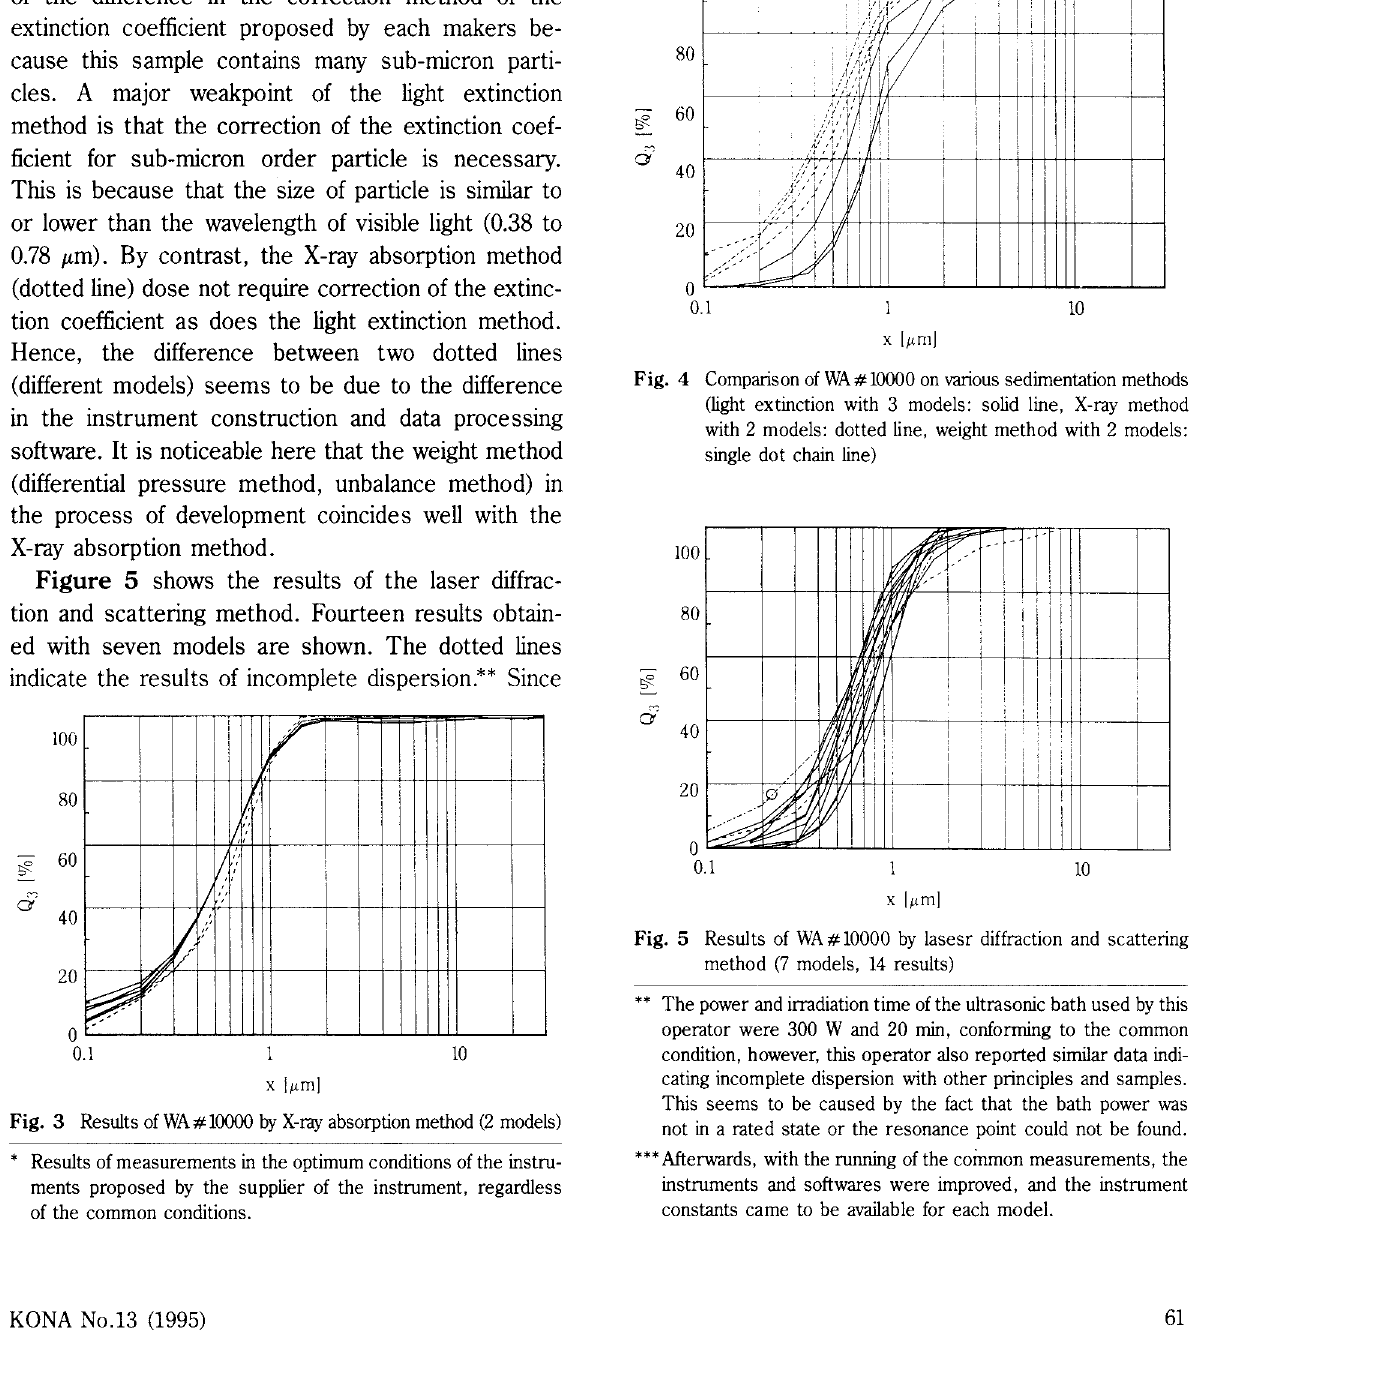
Fig. 3 Results ofWA#10000 by X-ray absorption method (2 models) * Results of measurements in the optimum conditions of the instru ments proposed by the supplier of the instrument, regardless of the common conditions.